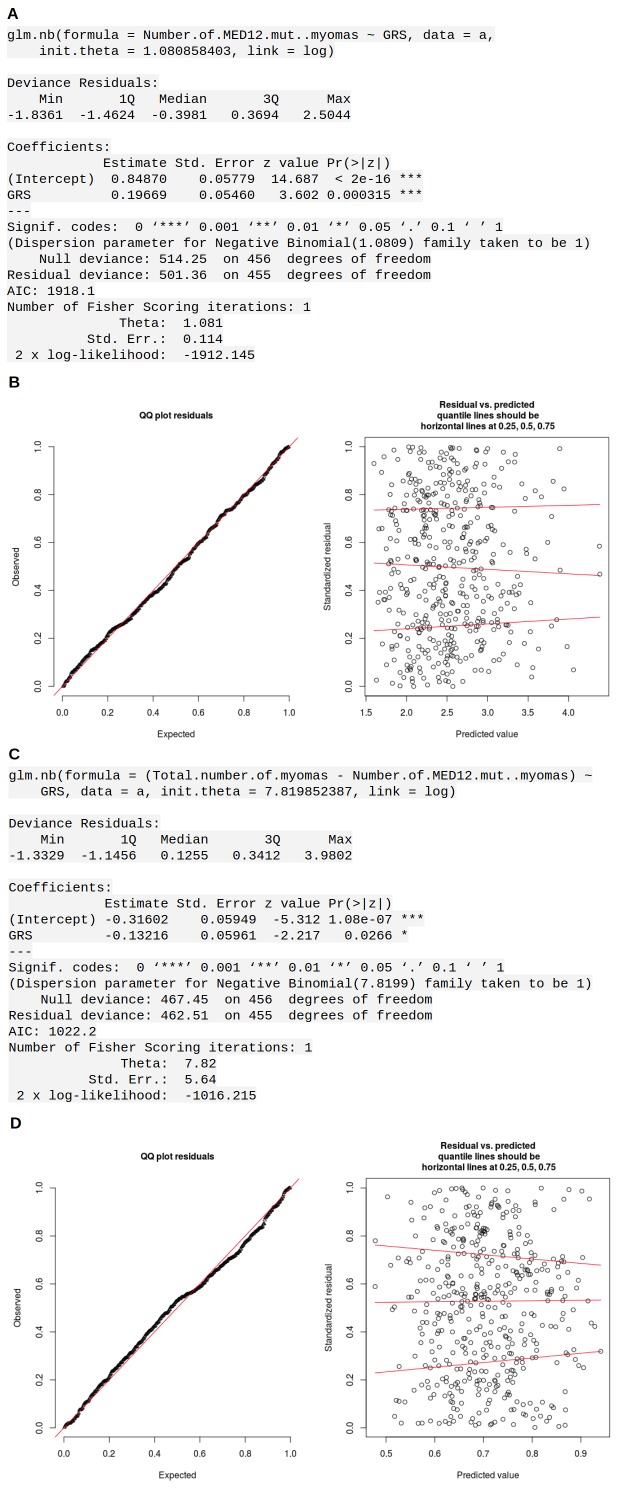
Association between GRS and MED12 mutations.The numbers are based on the Helsinki cohort data (457 patients). (A) summary of the negative binomial model for MED12-mutation-positive tumor counts. (B) diagnostic plots for the negative binomial model. (C, D) similar model for the MED12-mutation-negative tumor counts.